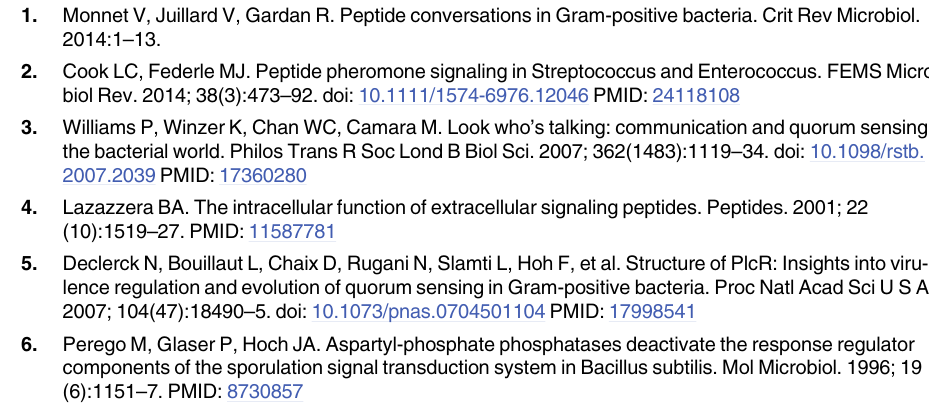
S2 Table. Primers used in this study. S3 Table. Plasmids used in this study. S4 Table. X-ray diffraction data processing and refinement